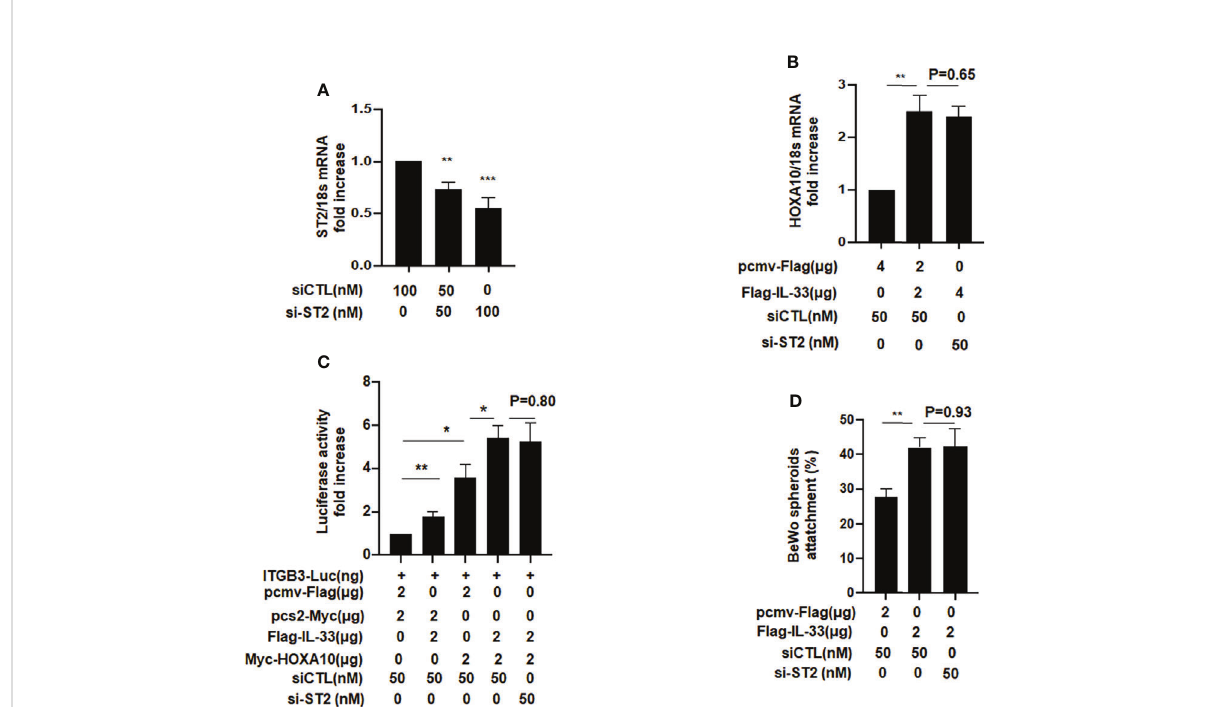
FIGURE 4 ST2 silence dose not affect the IL33-promoted HOXA10 expression and embryo implantation in vitro. (A) Ishikawa cells were transfected with si- ST2 or negative control. ST2 mRNA levels were measured by qRT-PCR ** p < 0.01, *** p < 0.001. (B) Ishikawa cells were transfected with si-ST2 or negative control. After 24h, IL33. was overexpression via the transfection of Flag-IL33. HOXA10 mRNA levels were measured by qRT-PCR. ** p < 0.01 (C) Ishikawa cells were transfected with si-ST2 or negative control. After 24h, ITGB3-Luc, Myc-HOXA10 (2 m g), and Flag-IL33 (2 m g) were transfected into the cells, as indicated. After 48 h, the luciferase activities were measured and are presented as fold induction. Values represent the mean ± SEM (n = 3), *p < 0.05, **p < 0.01. (D) BeWo spheroids (150 – 200 m m diameter) were attached to Ishikawa cells after 2 h. of co-culture. Adhesion experiments with BeWo spheroids attached to the Ishikawa cell monolayer. The data are the average of